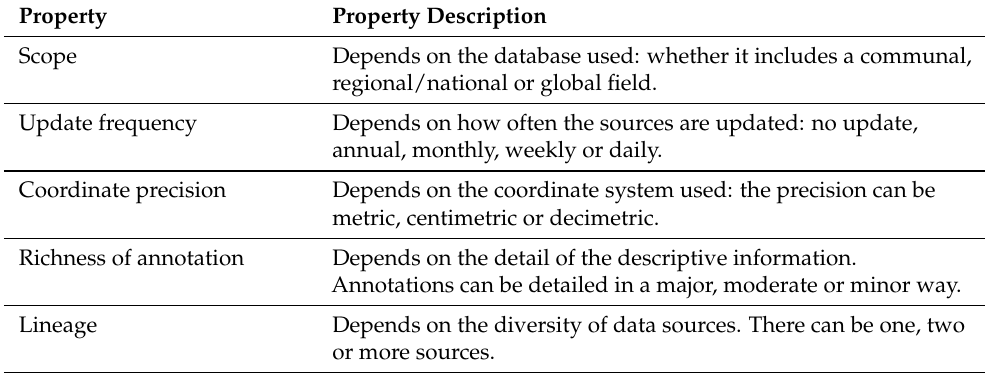
Table 1. Objectives non-functional properties, specific of geocoding services.